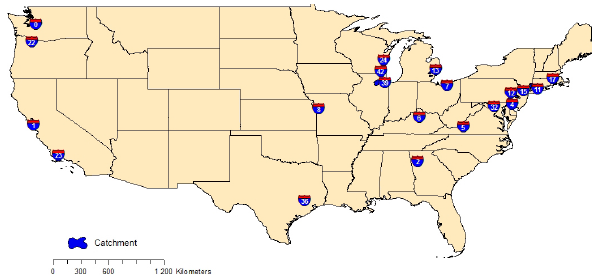
Figure 1. Location of the 43 studied catchments.